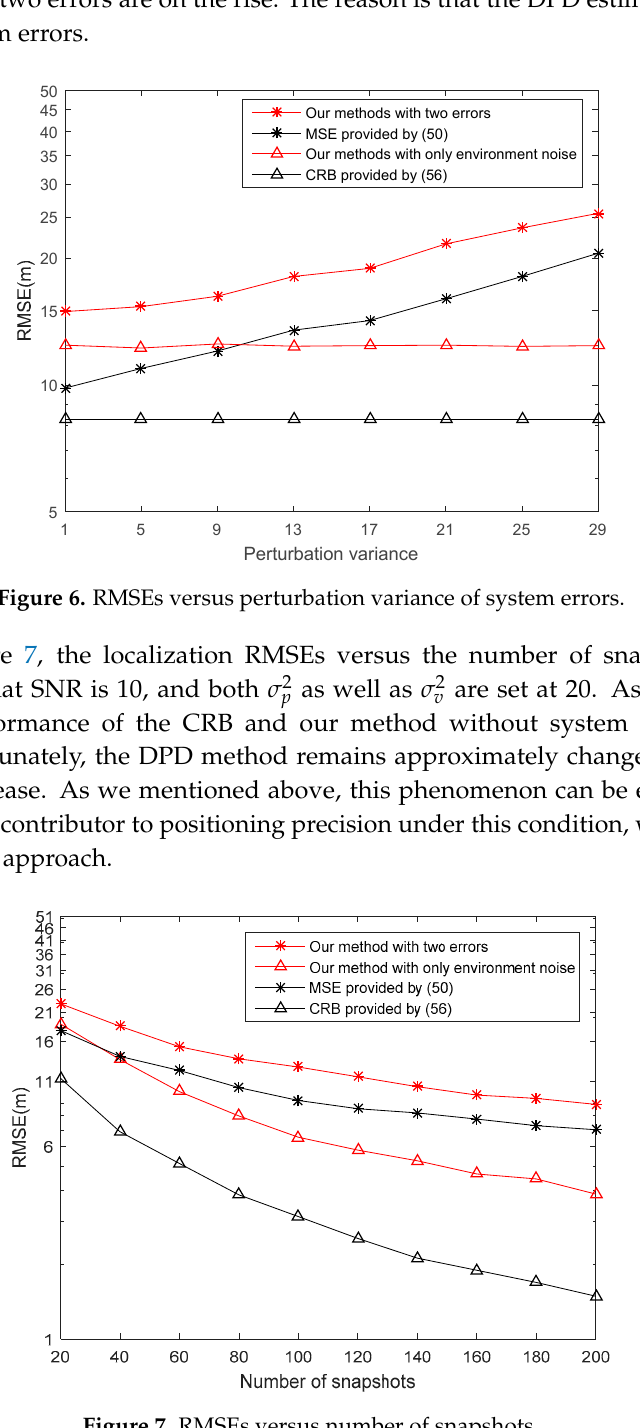
Figure 5. RMSEs versus SNR under different scenarios.